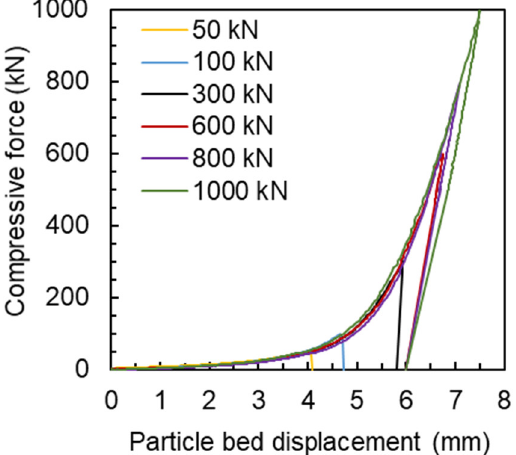
Figure 2. Load and unload force-displacement curves in tests up to different applied compressive forces for the Itabira sample contained in the size range of 150–125 µm.